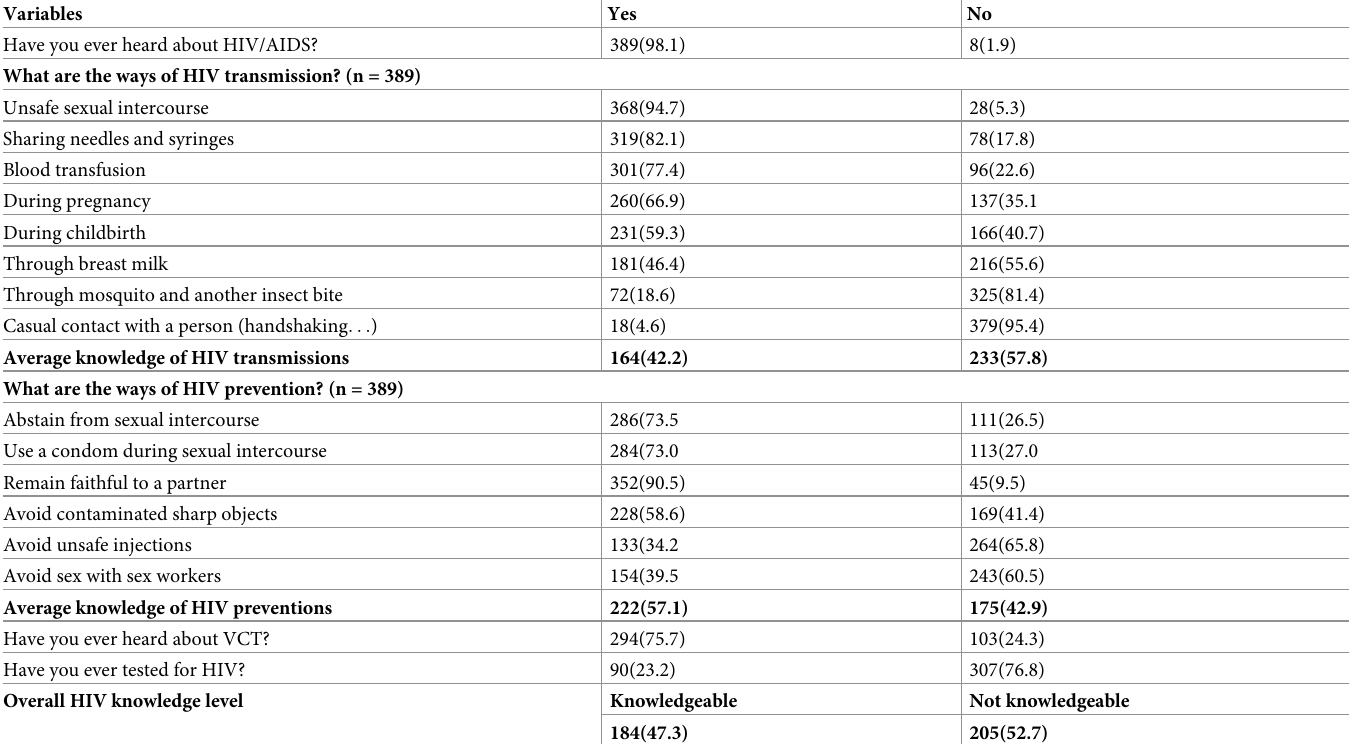
Table 3. The respondents’ knowledge of HIV/AIDS in North-shewa zone, Ethiopia,